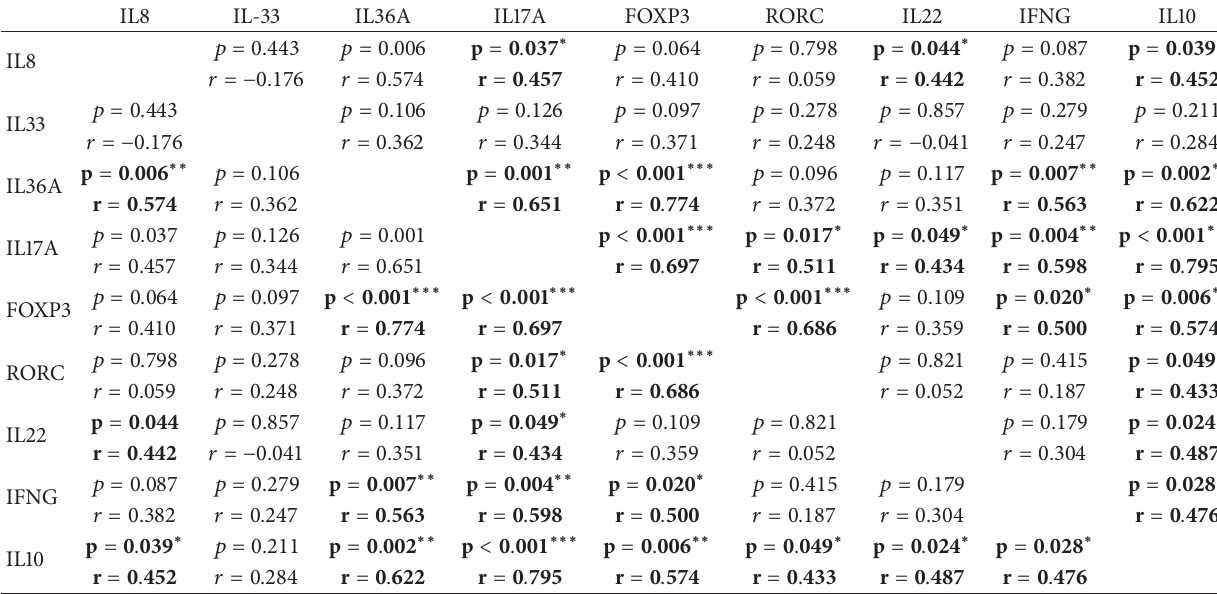
Table 2: Interplay among cytokines in human psoriasis lesions a .